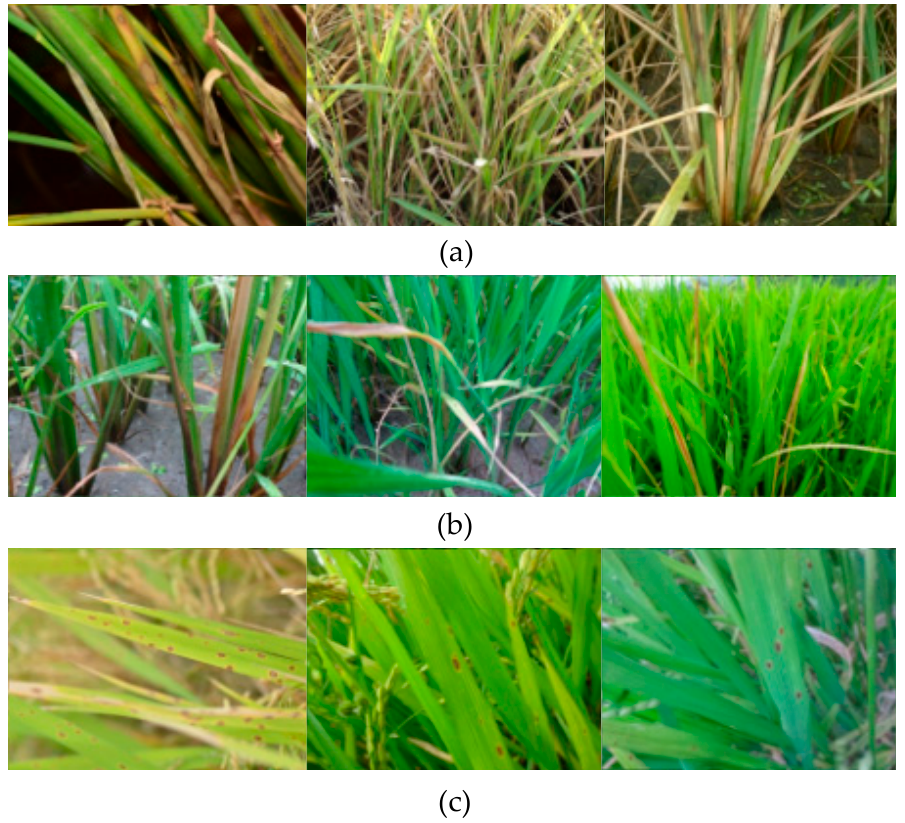
Figure 3. Images of the three kinds of rice diseases and pests. ( a ) Rice sheath blight, ( b ) rice stem borer symptoms, ( c ) rice brown spot. These images were collected in Anhui Province, etc., China, between June and August, 2018.